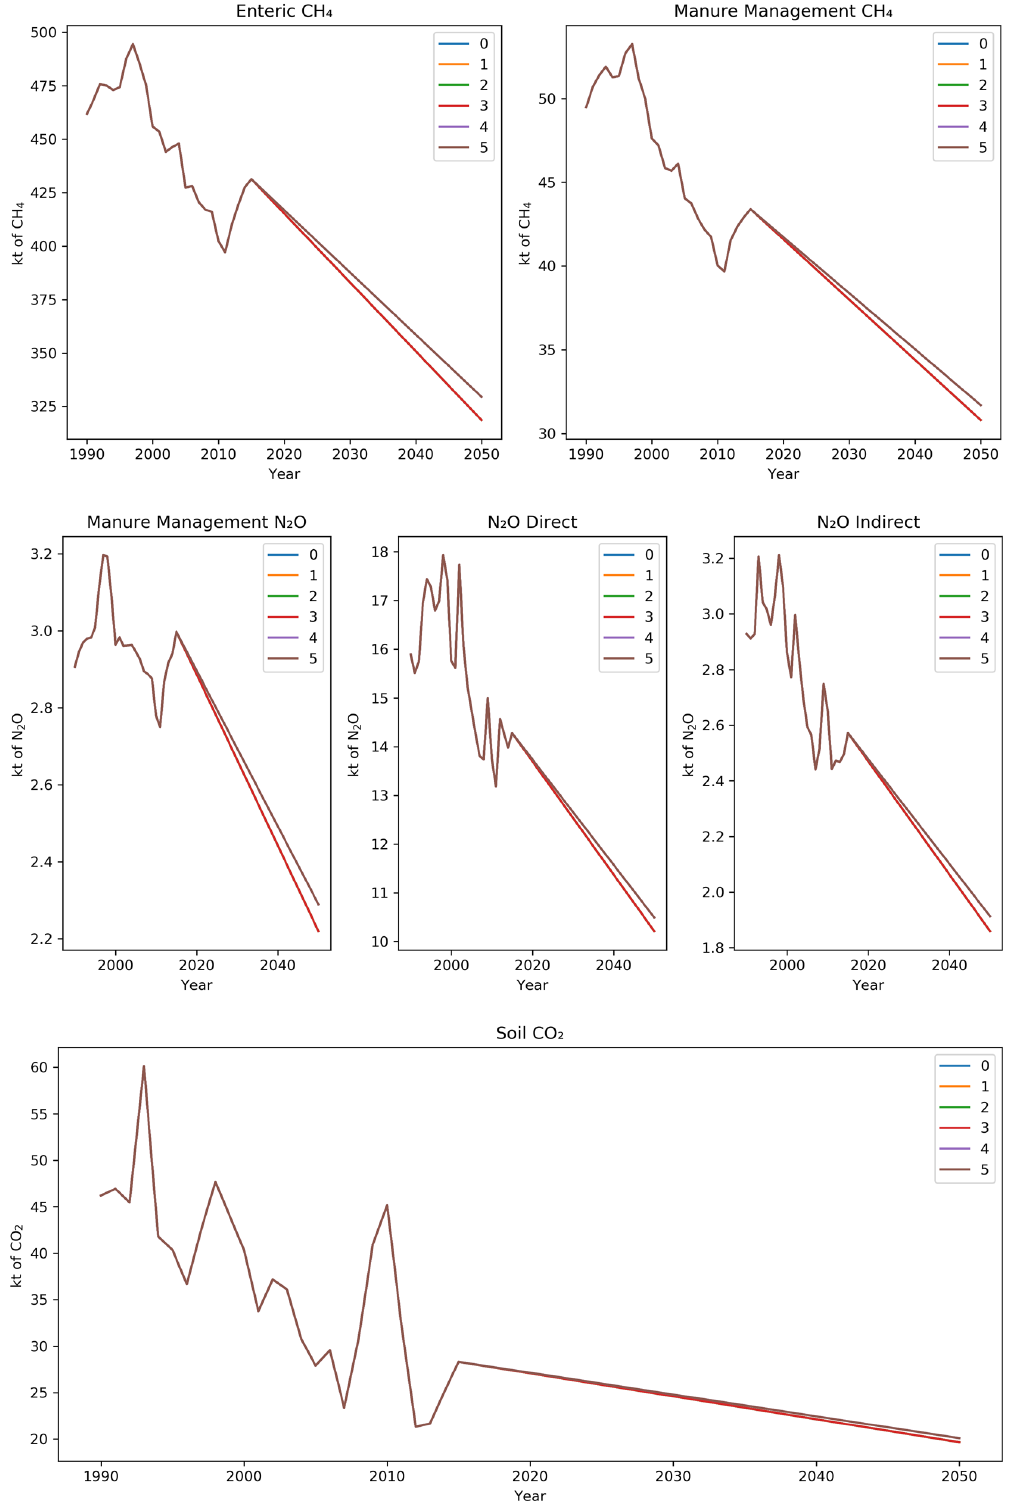
Figure 9. Summary of agricultural CH 4 , N 2 O, and CO 2 emissions from enteric fermentation, manure management, direct and indirect N 2 O sources, and synthetic fertiliser application to